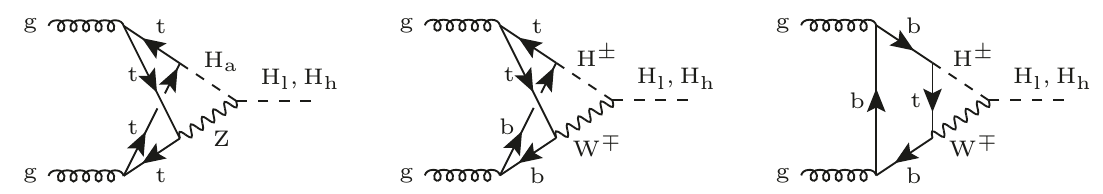
Figure 2 . Sample diagrams that do not appear in light Higgs-boson production in the alignment limit are shown. In the second and third diagram, the bottom quarks are considered to be massless. For light Higgs-boson production the contribution to the amplitude originating from these three diagrams is proportional to cos ( (cid:11) (cid:12) ). This is the reason why they vanish in the alignment (cid:0)